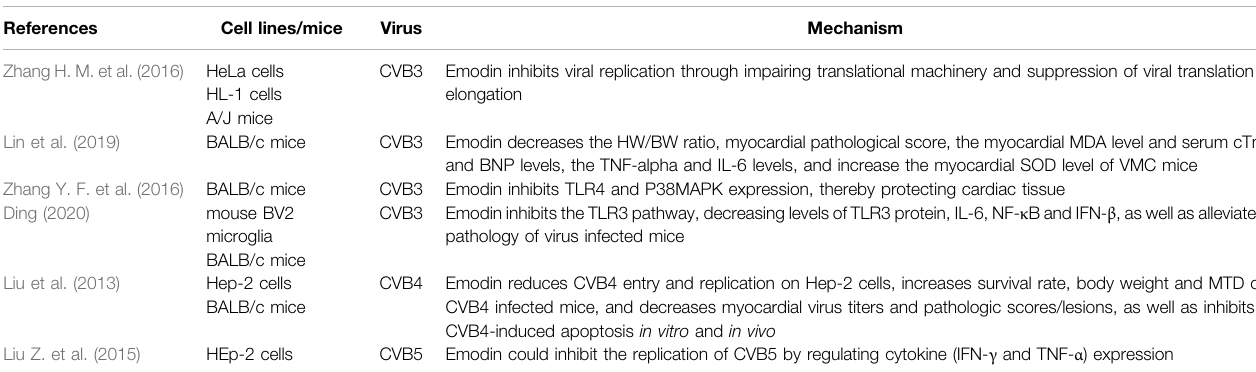
TABLE 4 | Anti-CVB activities of